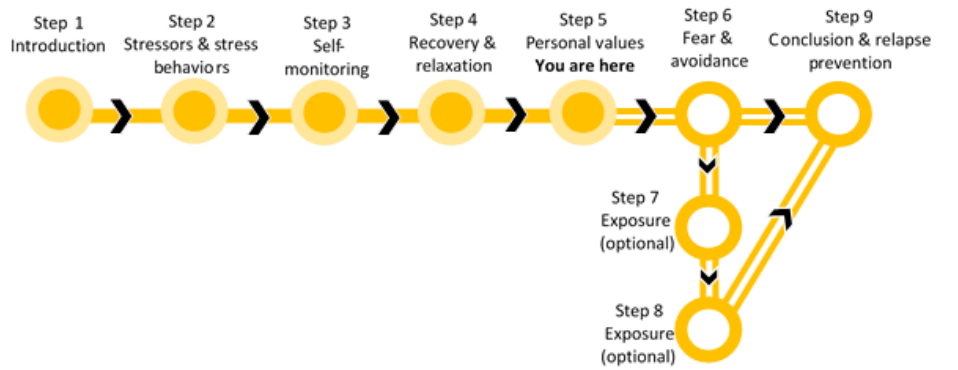
Figure 1. An overview of the steps in the